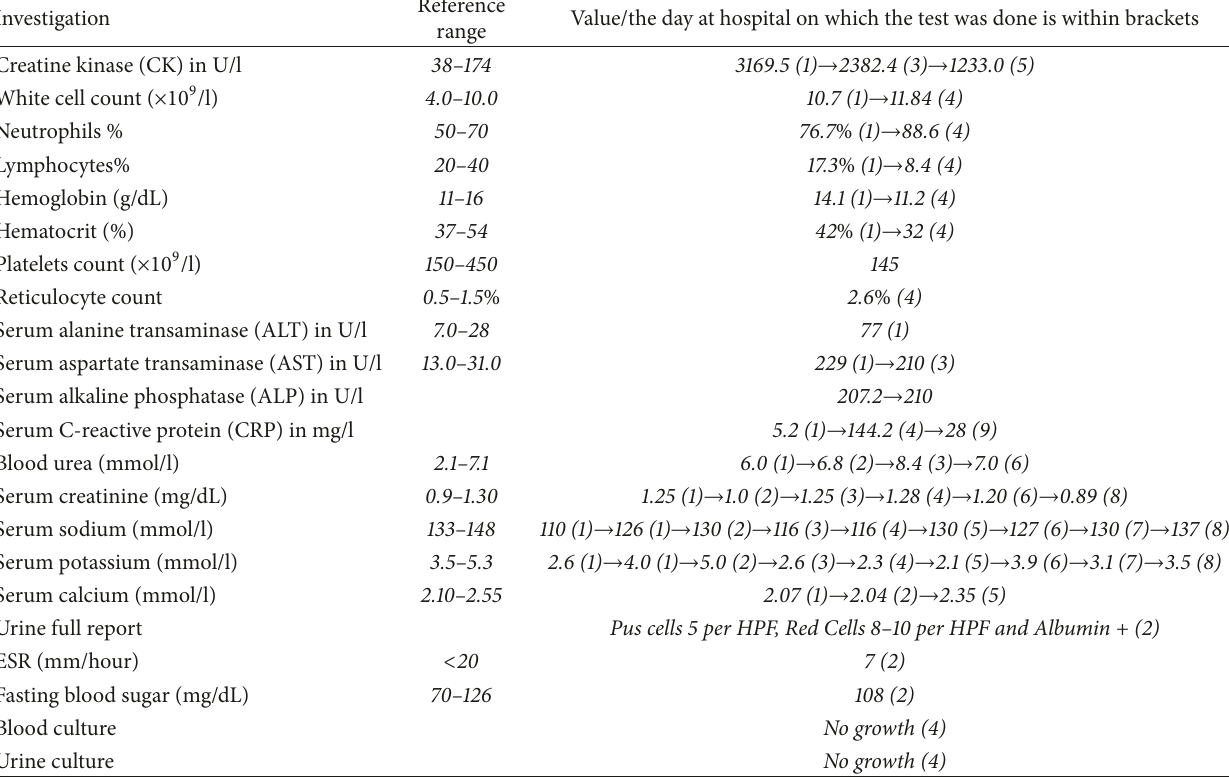
Table 1: The summery of the laboratory workup results of this